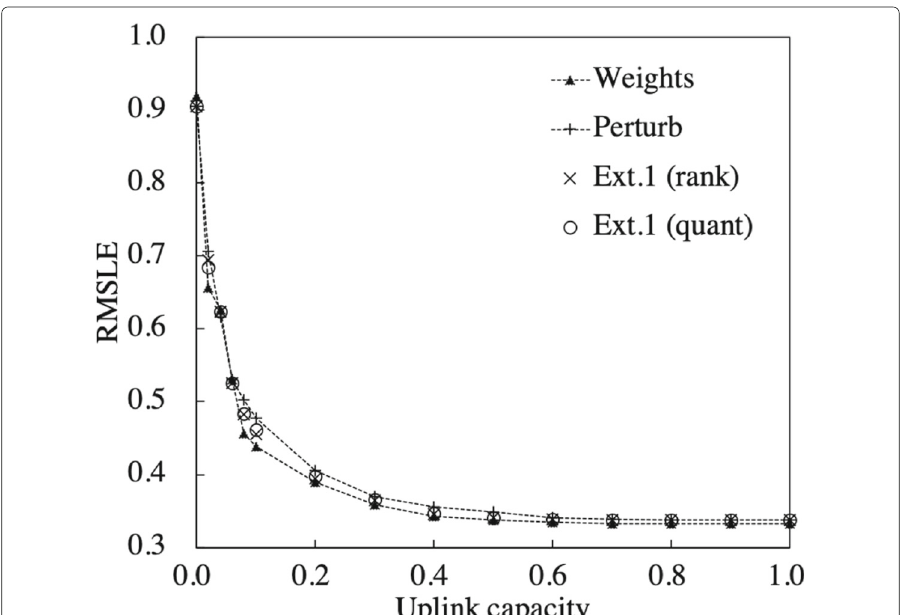
Fig. 7 Prediction accuracy (RMSLE) vs. uplink capacity obtained using LSTM for prediction. Perturb, weights, or extension scheme 1 with ranking and quantizing was used for feature selection